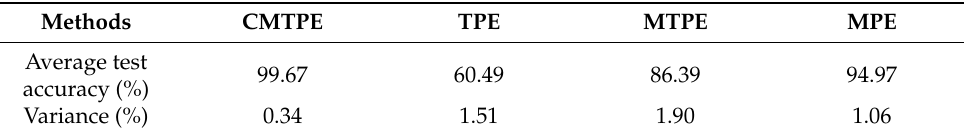
Table 4. Average test accuracy and variance of the four methods for different degrees of pitting